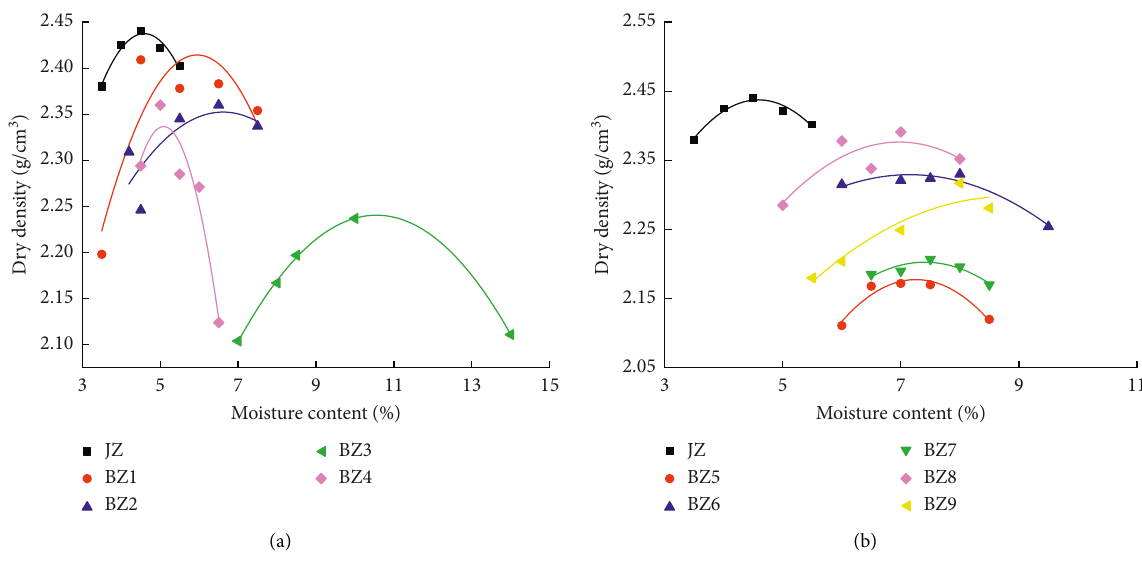
Figure 4: Curve of water content and dry density of all the samples. (a) BZ1 ∼ BZ4. (b) BZ5 ∼ BZ9. Table 2: Value of bets moisture content and dry density.